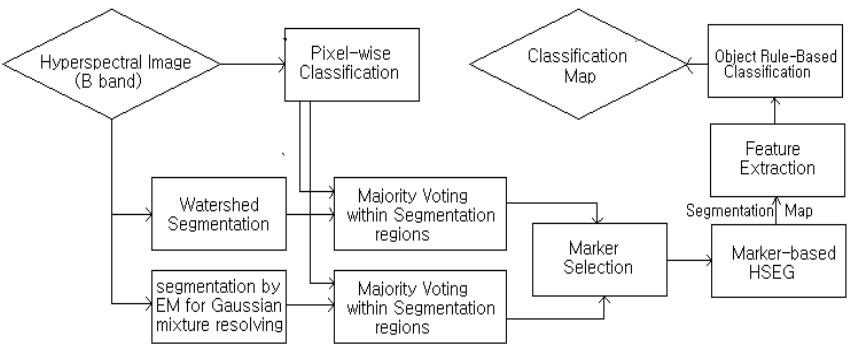
Figure 1. Flow-chart of the proposed classification